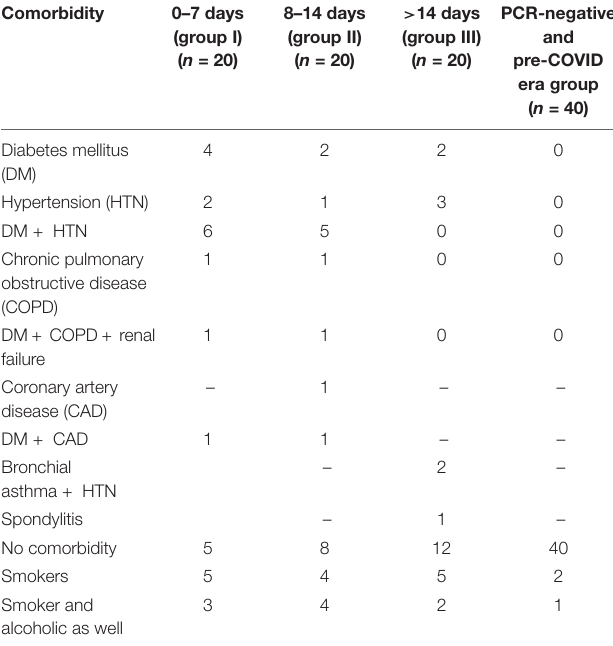
TABLE 1 | Distribution of various comorbidities among different study groups. Comorbidity